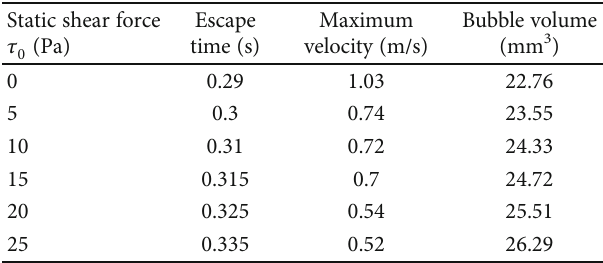
Table 3: Bubble escape time, maximum velocity, and volume for di ff erent static shear